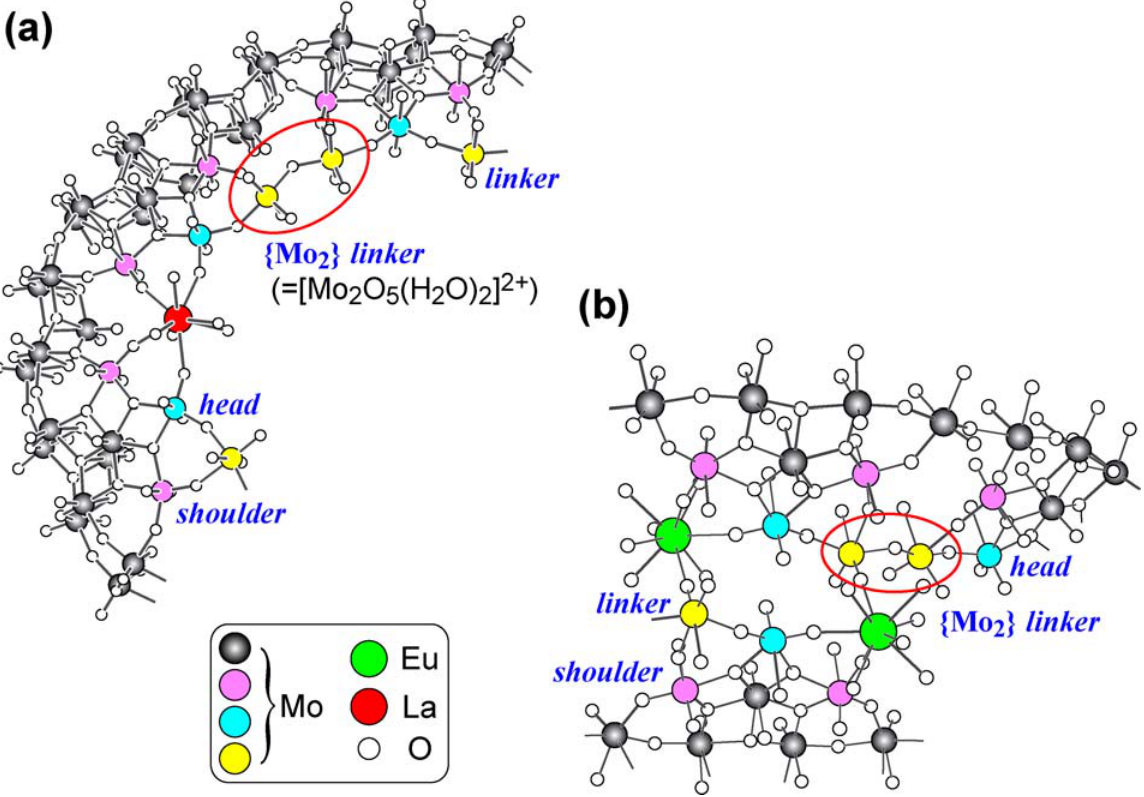
Figure 1. Environments of the La-coordination [2] in {Mo coordination [3] in {Mo shoulder , head and linker Mo sites,